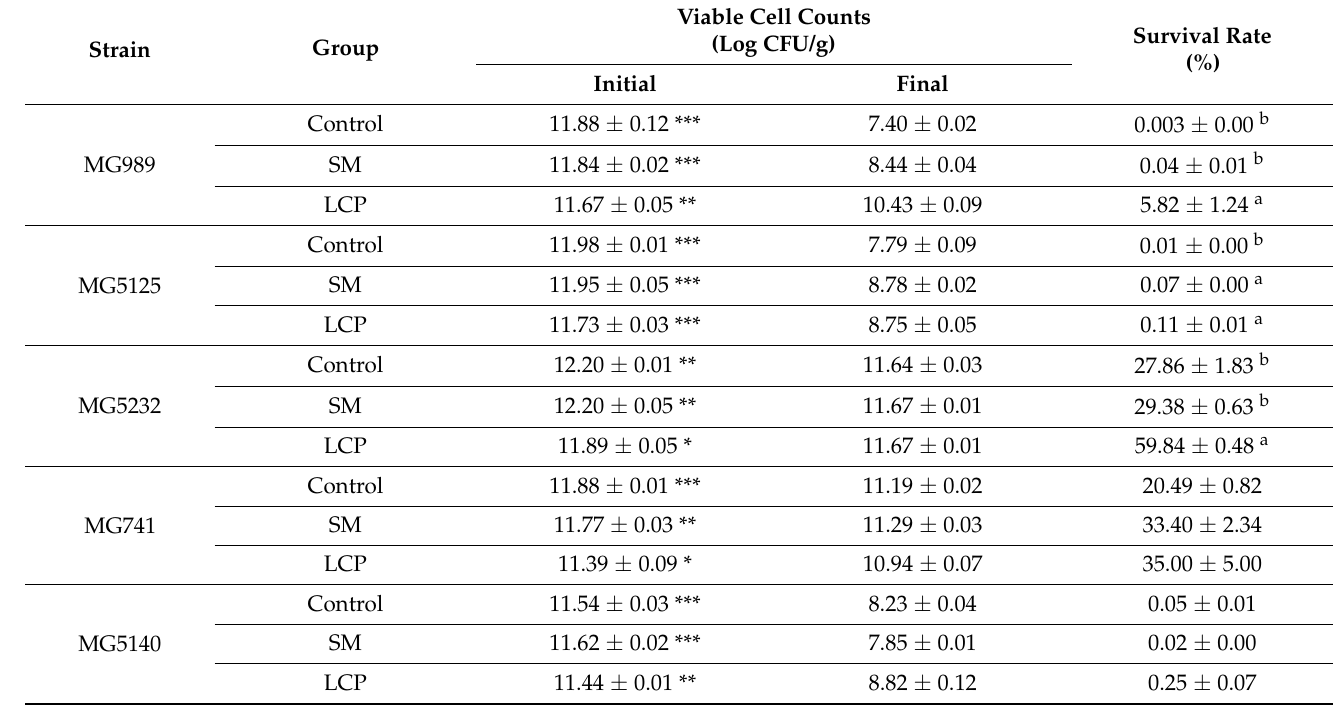
Table 3. Cell viability of freeze-dried lactic acid bacteria by heat treatment at 50 ◦ C for 30